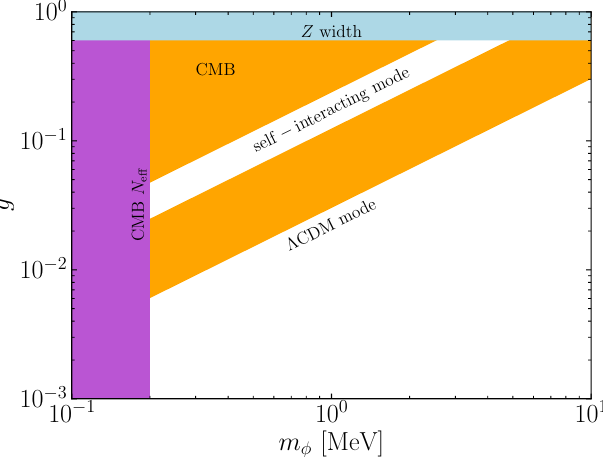
Figure 24.1: The various constraints on an interaction as described in Eq. (62). The new strongly interacting mode is identified by the diagonal white stripe through the orange CMB constrained